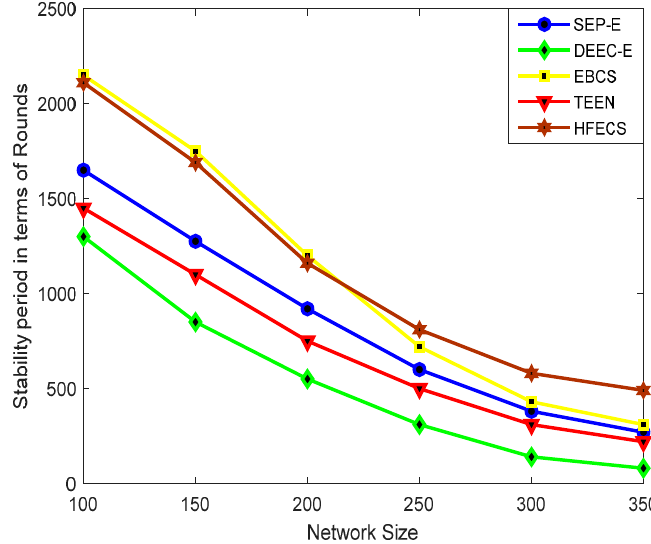
Figure 3. Stability period in terms of rounds against variable network size.